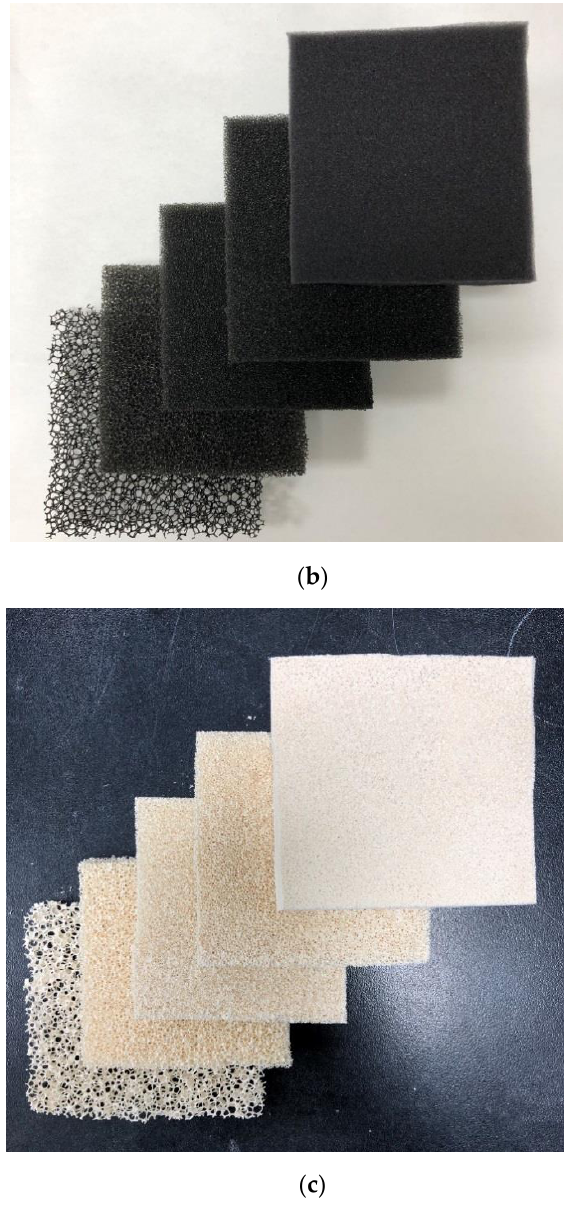
Figure 3. ( a ) Viscosities of ceramics slurries for the preparation of reticulated porous alumina and diatomite-kaolin composite. Optical images of ( b ) sacrificial polymer templates (commercial polyurethane) with pore densities of 10, 25, 45, 60, and 80 PPI, which were used as sacrificial polymer templates during the replica method (from left to right). ( c ) Reticulated porous diatomite-kaolin composite specimens with pore densities of 10, 25, 45, 60, and 80 PPI (from left to right).